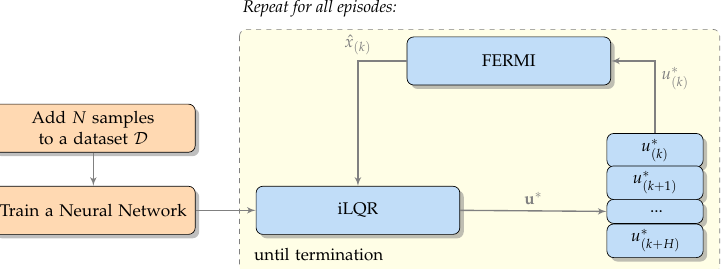
Figure 2. Schematic representation of a single run of the online iLQR. The termination occurs when I ( k ) ≥ 95% I ∗ , or when the control steps number exceeds N max .